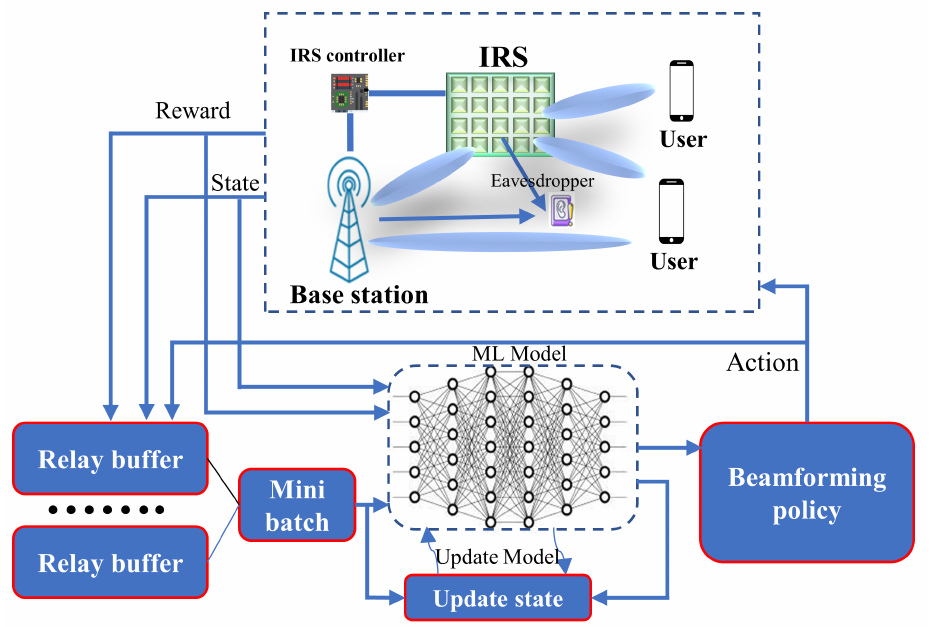
Figure 7. RL-based IRS-enhanced communication